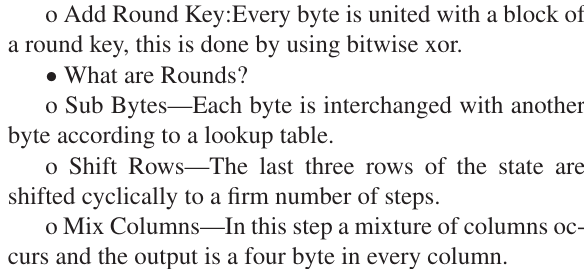
Figure 2. ENCRYPTION FLOWCHART